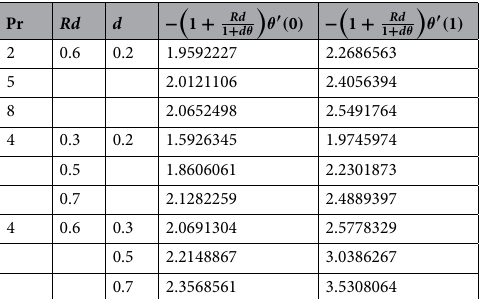
Table 3. Numeric values of the rate of heat transfer for growing values of Pr, Rd and d at both walls.